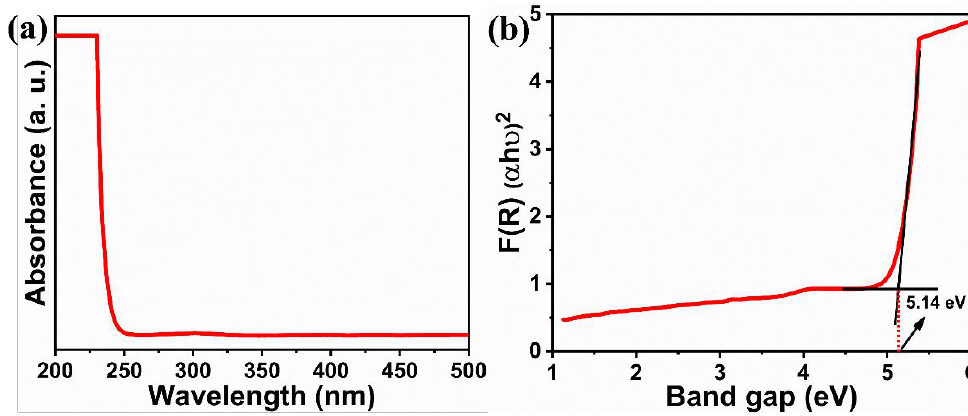
Figure 6. UV – Vis absorbance spectrum ( a ) and (b) determination of the band gap energy by the Kubelka – Munk function.